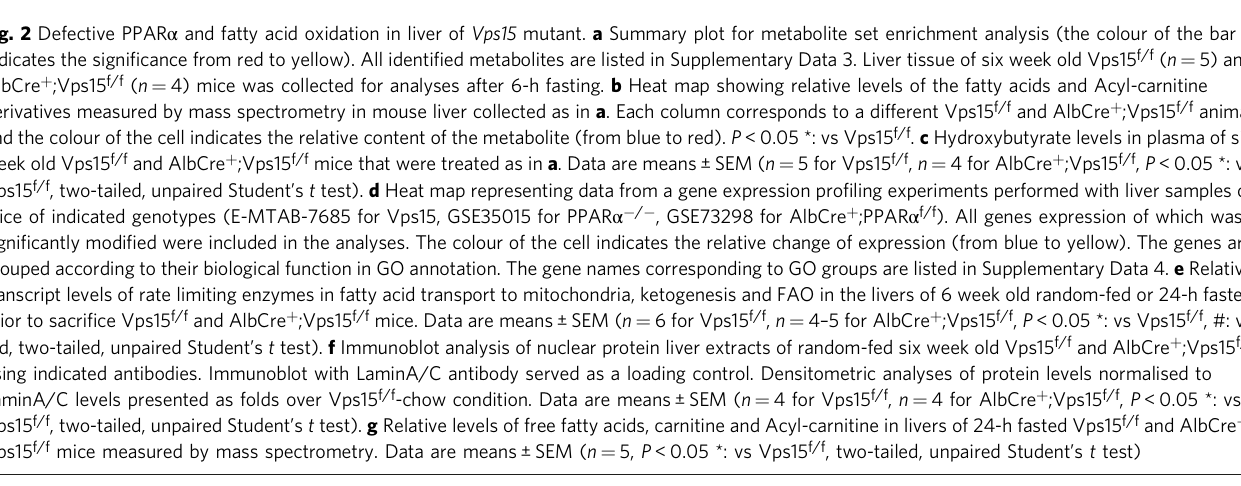
Fig. 2 Defective PPAR α and fatty acid oxidation in liver of Vps15 mutant. a Summary plot for metabolite set enrichment analysis (the colour of the bar indicates the signi fi cance from red to yellow). All identi fi ed metabolites are listed in Supplementary Data 3. Liver tissue of six week old Vps15 f/f ( n = 5) and AlbCre + ;Vps15 f/f ( n = 4) mice was collected for analyses after 6-h fasting. b Heat map showing relative levels of the fatty acids and Acyl-carnitine derivatives measured by mass spectrometry in mouse liver collected as in a . Each column corresponds to a different Vps15 f/f and AlbCre + ;Vps15 f/f animal and the colour of the cell indicates the relative content of the metabolite (from blue to red). P < 0.05 *: vs Vps15 f/f . c Hydroxybutyrate levels in plasma of six week old Vps15 f/f and AlbCre + ;Vps15 f/f mice that were treated as in a . Data are means± SEM ( n = 5 for Vps15 f/f , n = 4 for AlbCre + ;Vps15 f/f , P <0.05 *: vs Vps15 f/f , two-tailed, unpaired Student ’ s t test). d Heat map representing data from a gene expression pro fi ling experiments performed with liver samples of